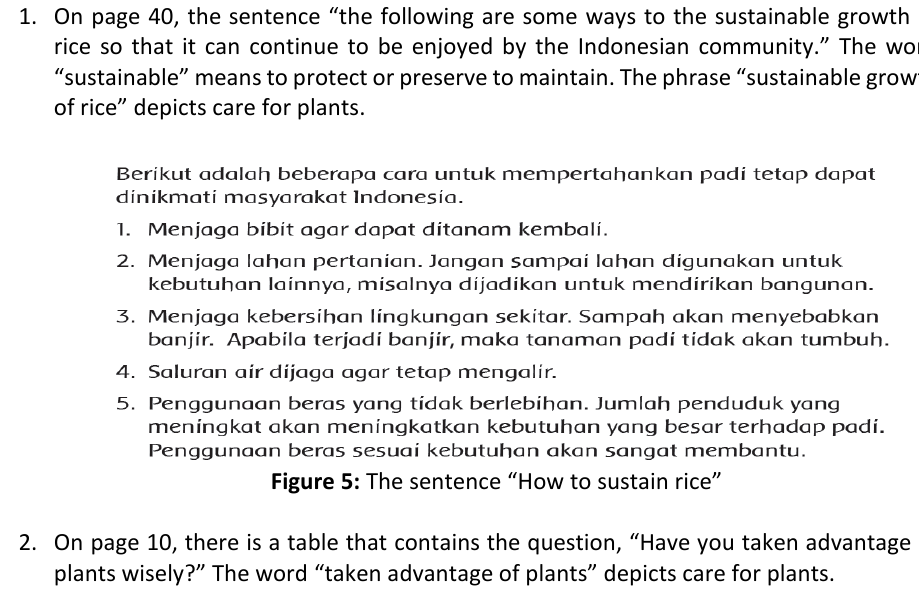
Figure 5: The sentence “How to sustain